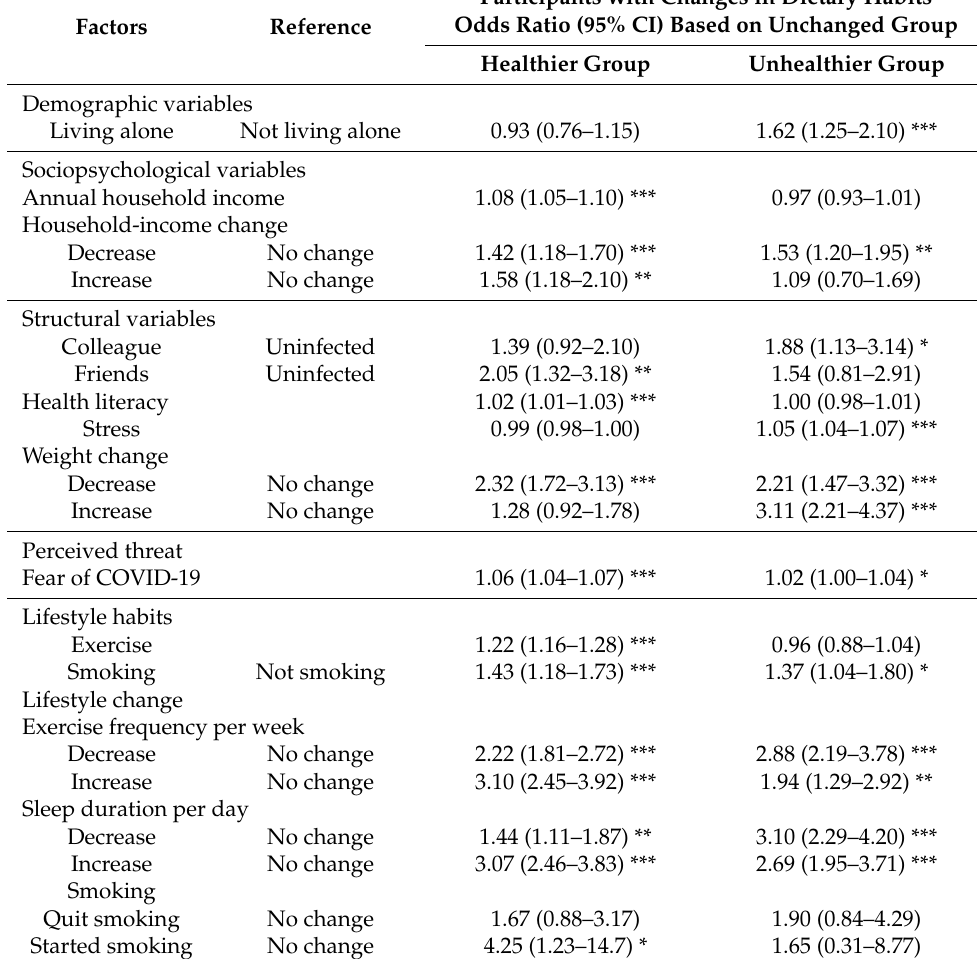
Table 5. Multinomial logistic regression analyses of the factors associated with change in dietary